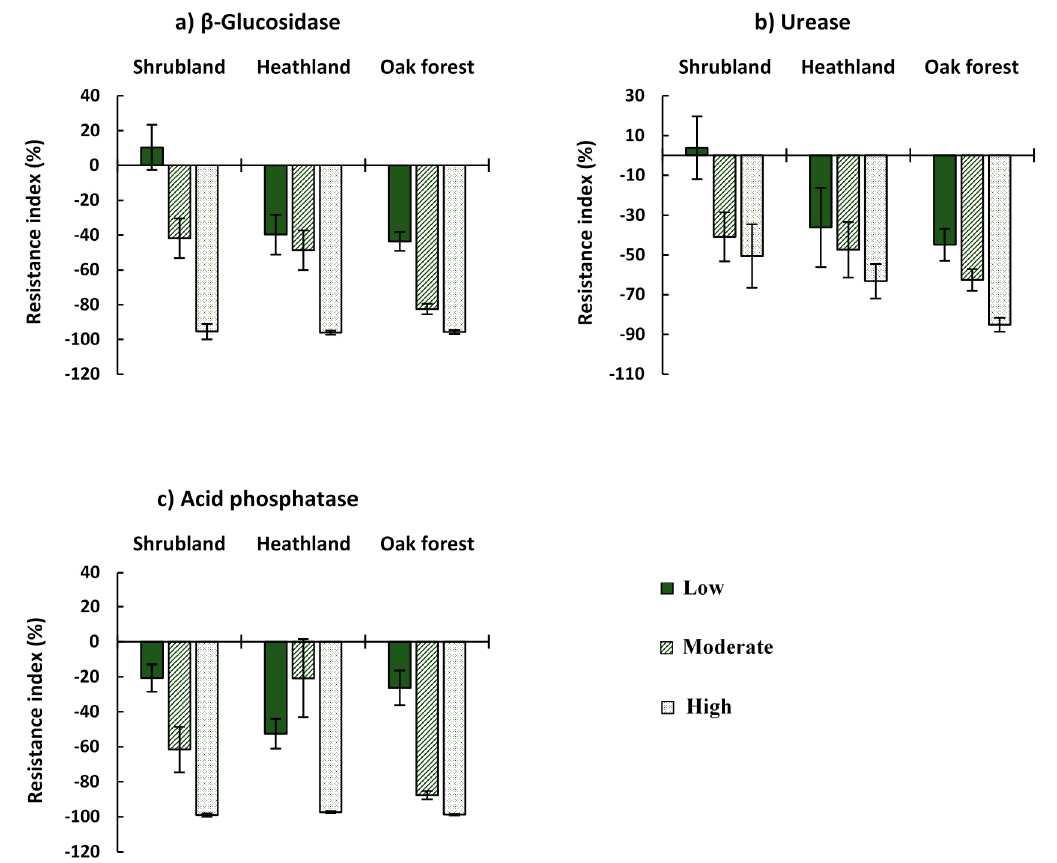
Figure 5. Average ( a ) β -glucosidase, ( b ) urease, and ( c ) acid phosphatase resistance index values and standard error for each forestry ecosystem (shrubland, heathland, and oak forest) and burn severity level (low, moderate, and high) measured by the Composite Burn Index (CBI).